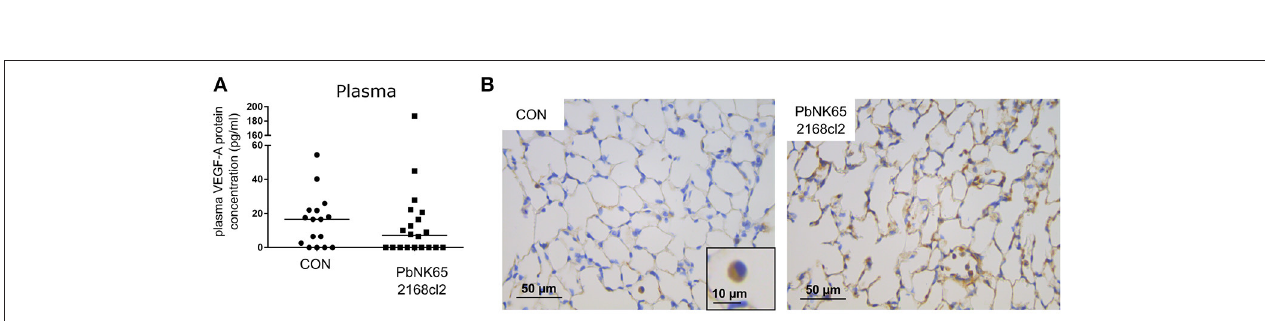
FIGURE 3 | Plasma levels and pulmonary immunohistochemical detection of VEGF-A in murine MA-ARDS. C57BL/6 mice were infected with PbNK65 2168cl2. (A) Plasma levels of VEGF-A were determined at day 7 pi. Compilation of four experiments, n = 16–20. (B) Paraffin sections were prepared from lungs of uninfected (CON) and infected mice, and stained with anti-VEGF-A monoclonal antibody (brown). Representative images are shown in 40x/0.65 magnification (scale bars, 10mm), n = 2–4.